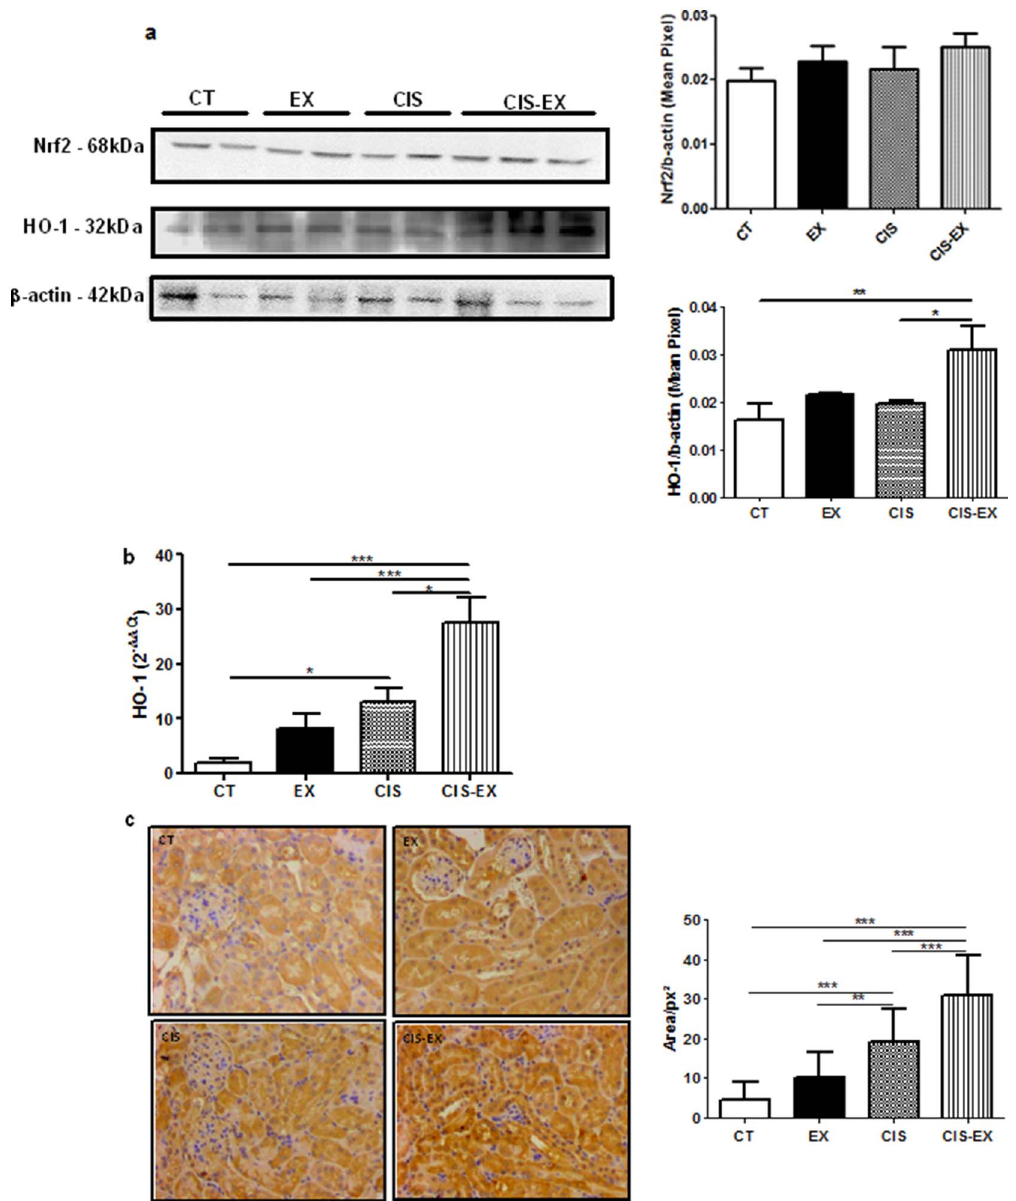
Figure 5. Exercise promotes increased HO-1 expression. Nrf2 and HO-1 expression in the kidney were evaluated by Western Blot ( left – representative image and right – quantification). Exercise induced HO-1 gene expression, as confirmed by qPCR ( B ), and the levels of HO-1 in the renal tissue were analyzed by immunohistochemistry ( C , left – representative image and right – quantification). *P , 0.05; **P , 0.01; ***P , 0.001.